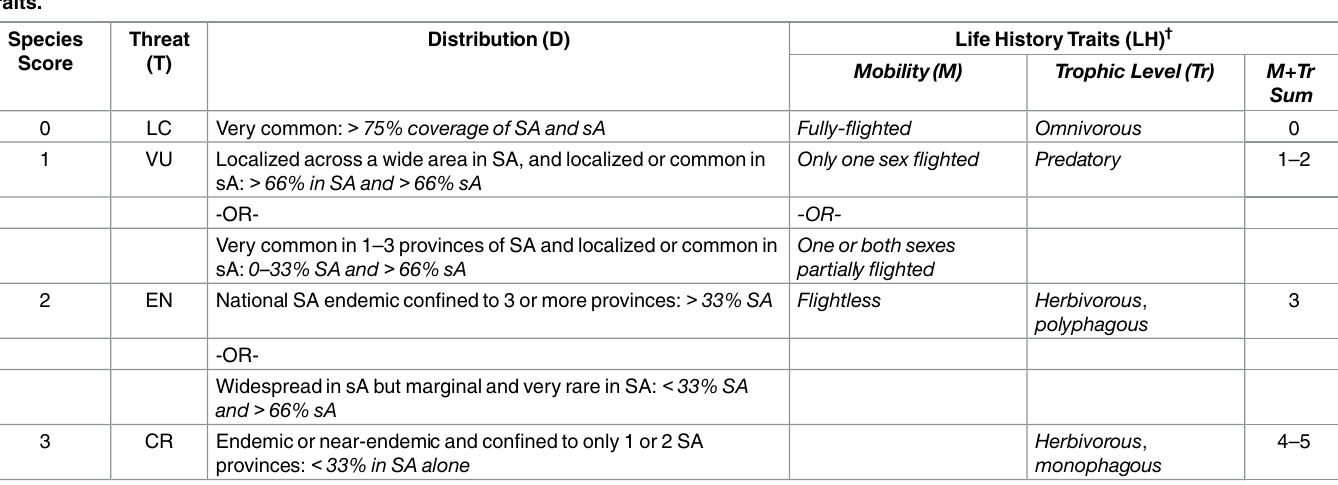
Each of the three categoriesis scored from 0 to 3, and the categoriescan be summedin different combinations to give each katydid species a score ranging from 0 to 9, with the higher the score, the more threatened, narrowly distributed,and specialized the katydid species. Threatscores are given in accordance with IUCN Red List categoriesand distributionscores are indicative of the number of countries(southern Africa)and provinces (South Africa)in which the species is found. Life historyscores are awarded on the basis of a species’ mobility and its trophic level. SA = South Africa,Lesotho, and Swaziland and sA = southernAfrica(South Africa,Lesotho, Swaziland, Namibia, Botswana and Zimbabwe). † To calculateLH score, M (range 0–2) + Tr (range 0–3) are summed.The sum is assigned a logical species score (range